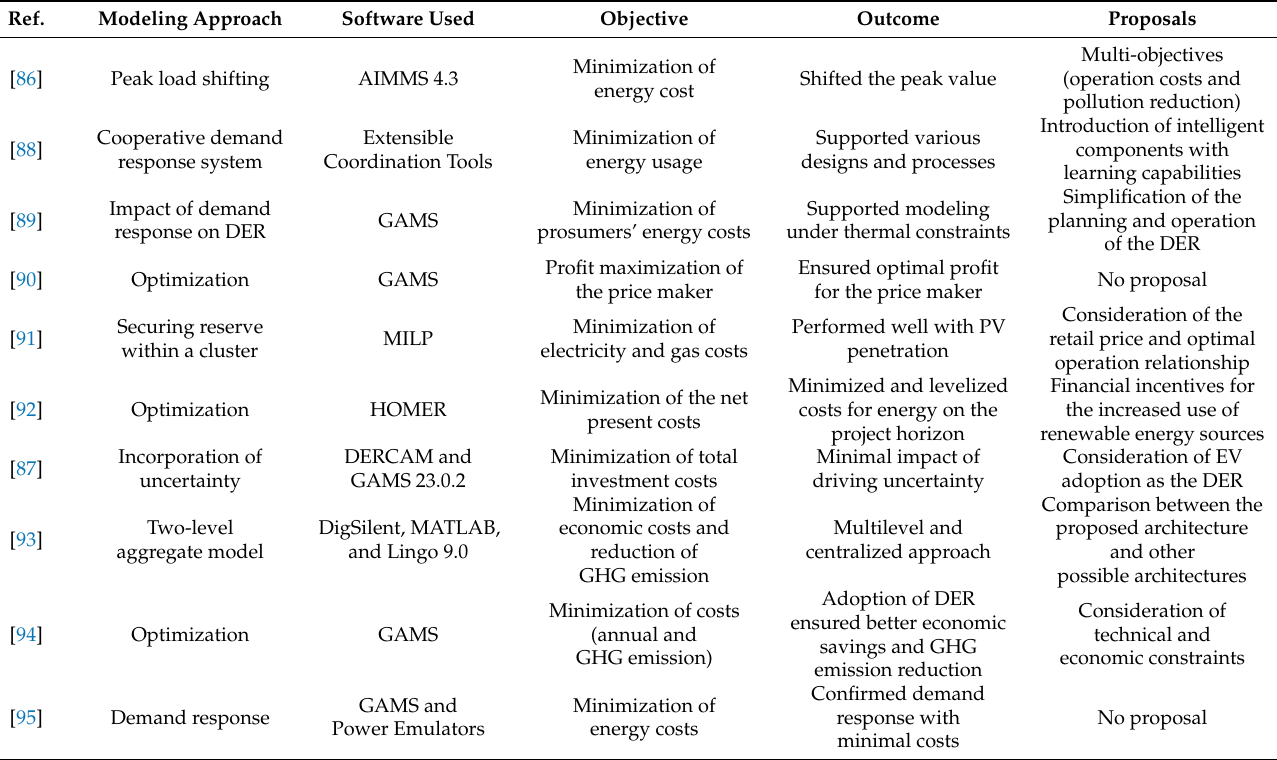
Table 2. Smart city energy model